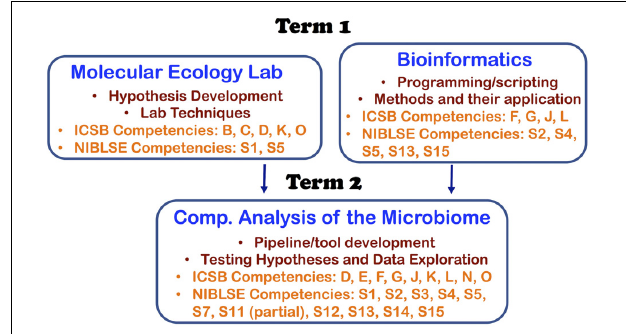
FIGURE 1 | Each course in the sequence and its mapping to ICSB and NIBLSE competencies.